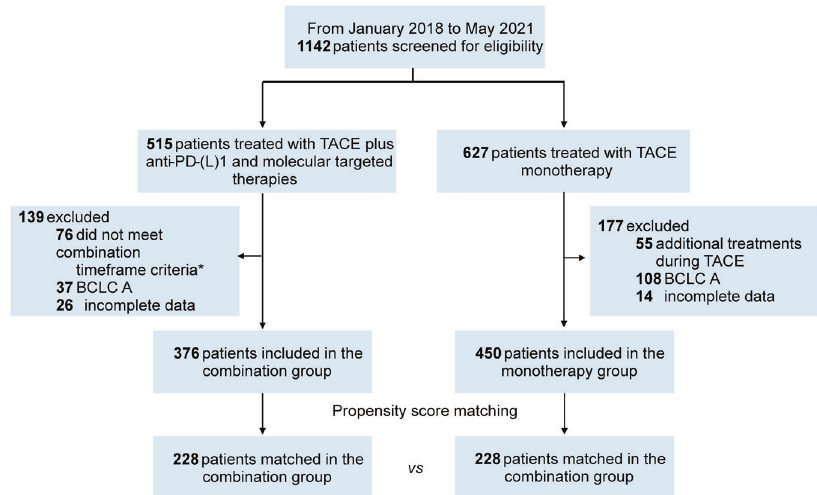
Fig. 1 Flowchart of the study. *The criteria of combination timeframe were de fi ned as administration of TACE concurrently with or up to 60 days before anti-PD-(L)1 blockades, and molecular targeted agents were concomitant with TACE or anti-PD-(L)1 blockades.